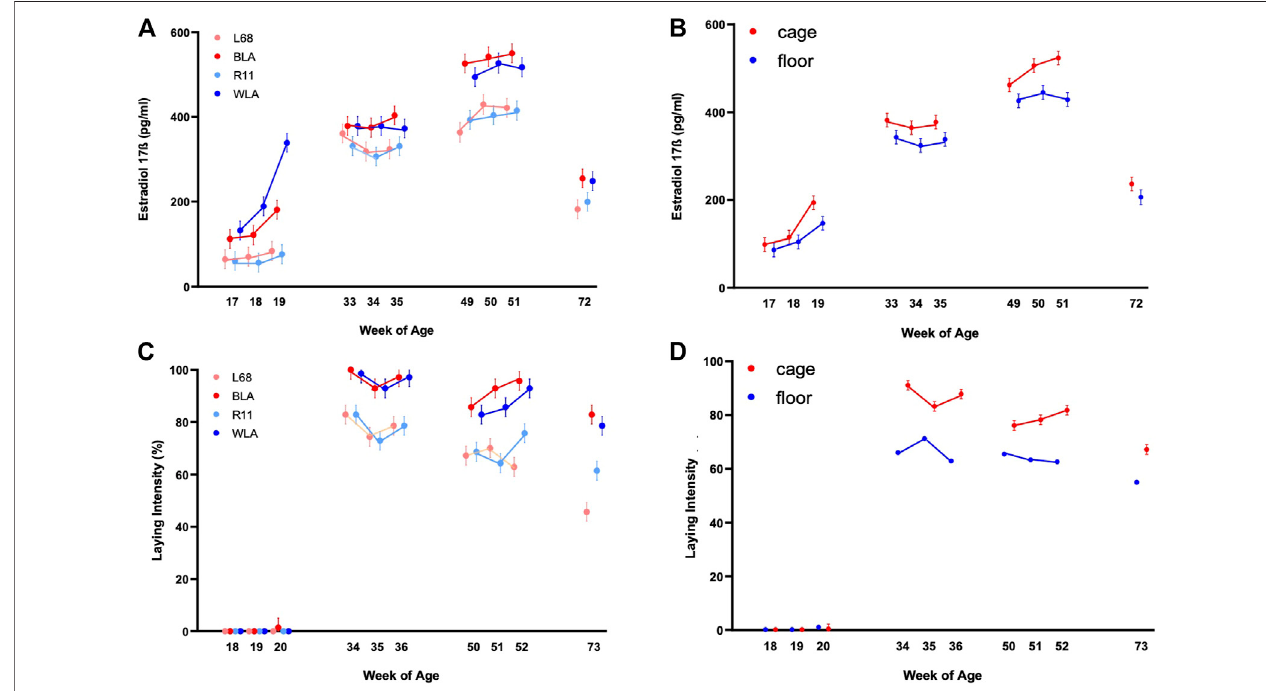
FIGURE1 | Estradiol-17ßblood plasmaconcentration (pg/ml) and laying intensity (%) offour different layer lines kept indifferenthousing systems and investigated at fourtimeperiods (17th,18th,and 19thweekofage(beforestartoflaying);33rd,34th,and35thweekofage(maximumofeggproduction); 49th,50th,and51st week ofage(decreaseineggproductioninlowproducinglines)and72ndweekofage(endofexperiment).Thelayingintensityisshownaftereachweekofbloodsampling (A) Estradiol-17ßconcentrationofthetwohighperforminglayerlines(WLA,BLA)andthetwolowperforminglayerlines(L68,R11)respectivelycage-housedand fl oor- housed laying hens (B) , consisting of WLA, BLA, L68, and R11 hens) during their laying period (C) Laying intensity of all four-layer lines and of cage-housed and fl oor- housed laying hens (D) during their laying